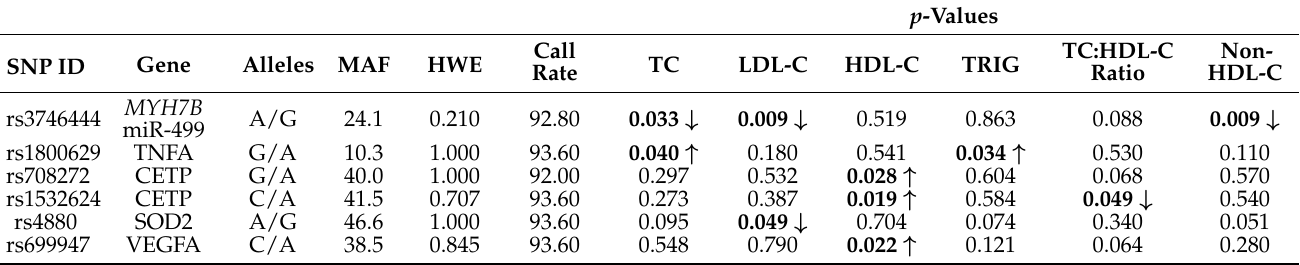
Table 3. Associations between polymorphisms and lipid profile in 125 subjects with moderate